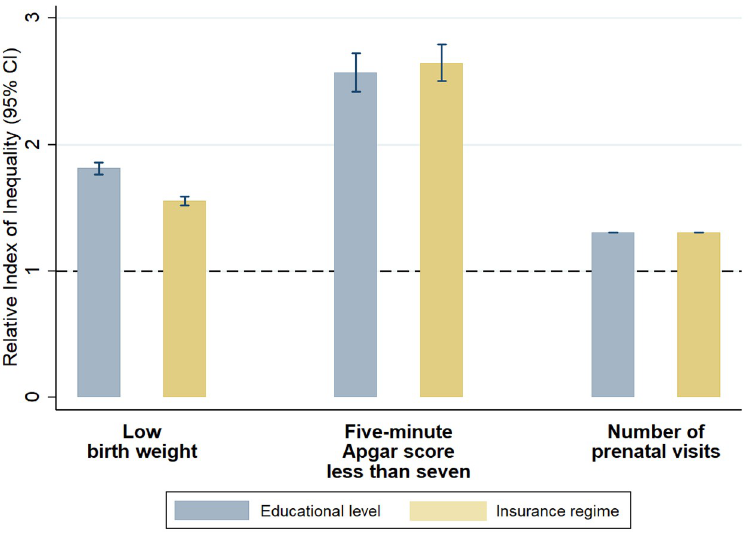
Fig 1. Relative indexes of inequality in birth outcomes and prenatal care by maternal education level and health insurance scheme (including all included births from 2008 to 2018).